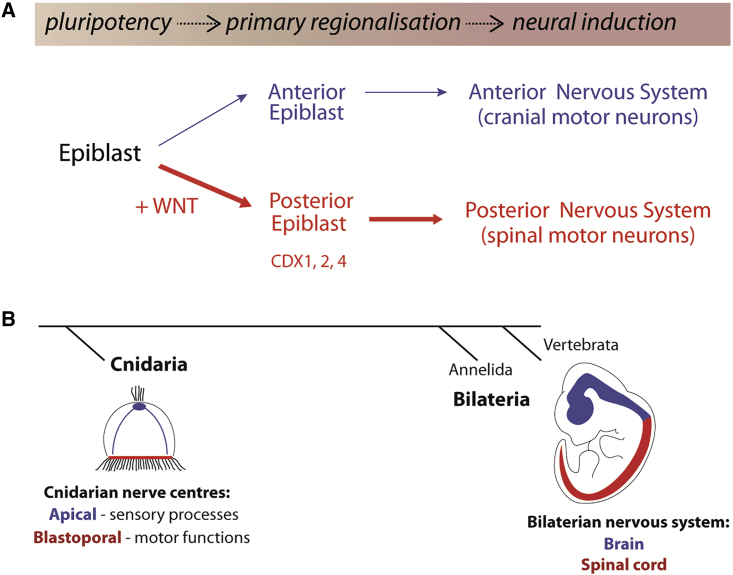
Proposed Model of Nervous System Development(A) Pluripotent epiblast cells in the early embryo are first allocated into anterior (blue) or posterior (red) populations before acquiring neural identity. Posteriorized cells form spinal cord; anterior epiblast cells generate the anterior nervous system.(B) Comparisons between cnidarian and bilaterian animals provide support for the dual evolutionary origin of the vertebrate CNS (Arendt et al., 2016). Cnidarians display two distinct nerve centers: apical (blue) and blastoporal (red). Blastoporal centers show expression of putative CDX orthologs (Arendt et al., 2016, Ryan et al., 2007). In bilaterians, these separate nerve centers are proposed to have expanded and merged.